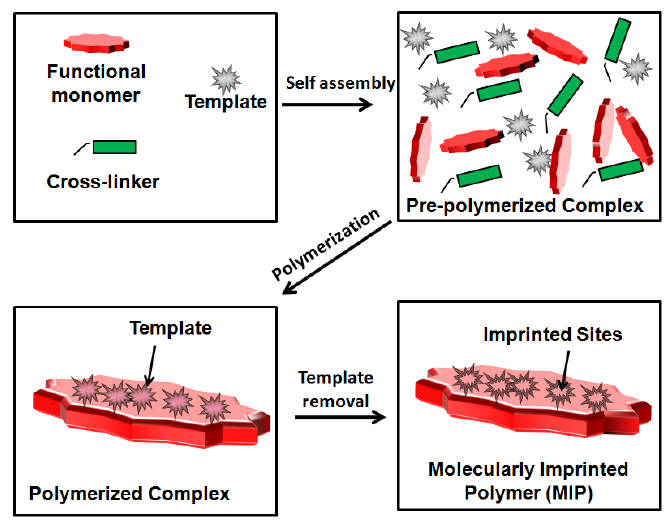
Figure 4. General mechanism of molecular imprinting technique for creating recognition sites for specific template realization.